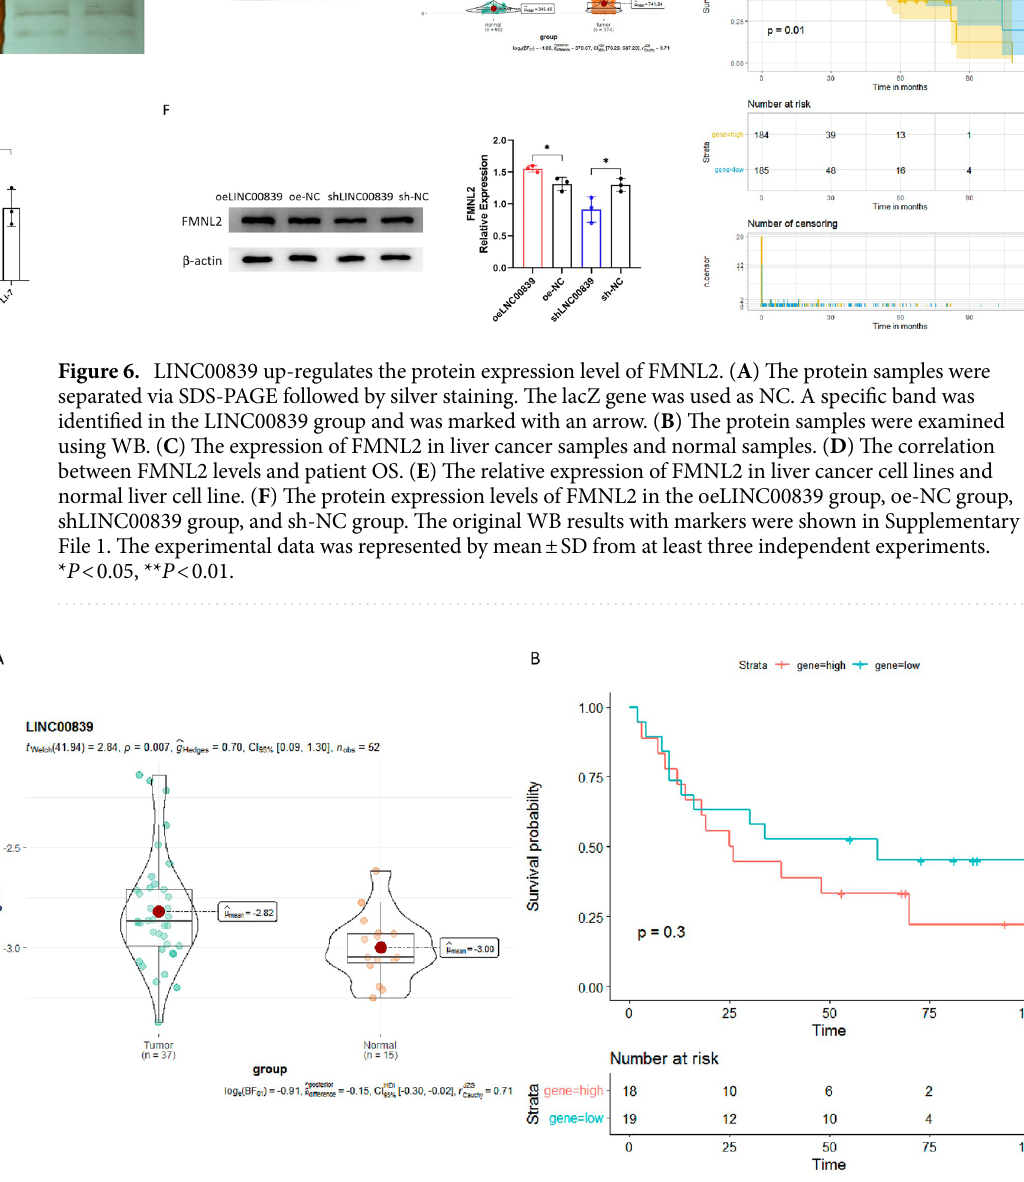
Figure 7. LINC00839 is up-regulated in HCC tissues and correlates with poor OS. ( A ) The LINC00839 expression levels in liver cancer tissue samples (n = 37) and adjacent nontumoral liver tissue samples (n = 15). ( B ) The correlation between LINC00839 levels and patient